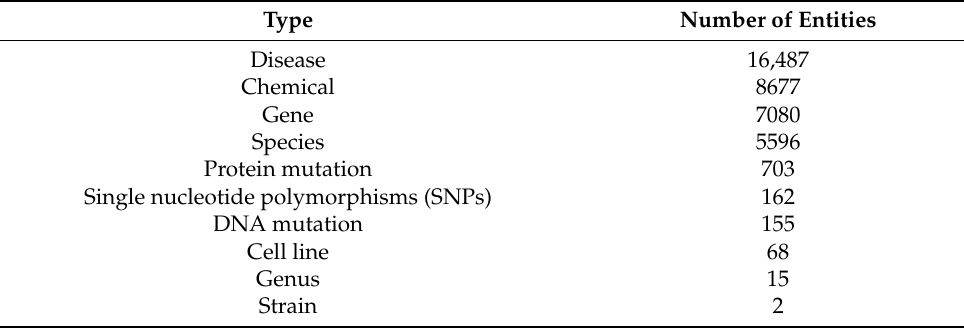
Table 3. Descriptive statistics of entities extracted from CORD-19.